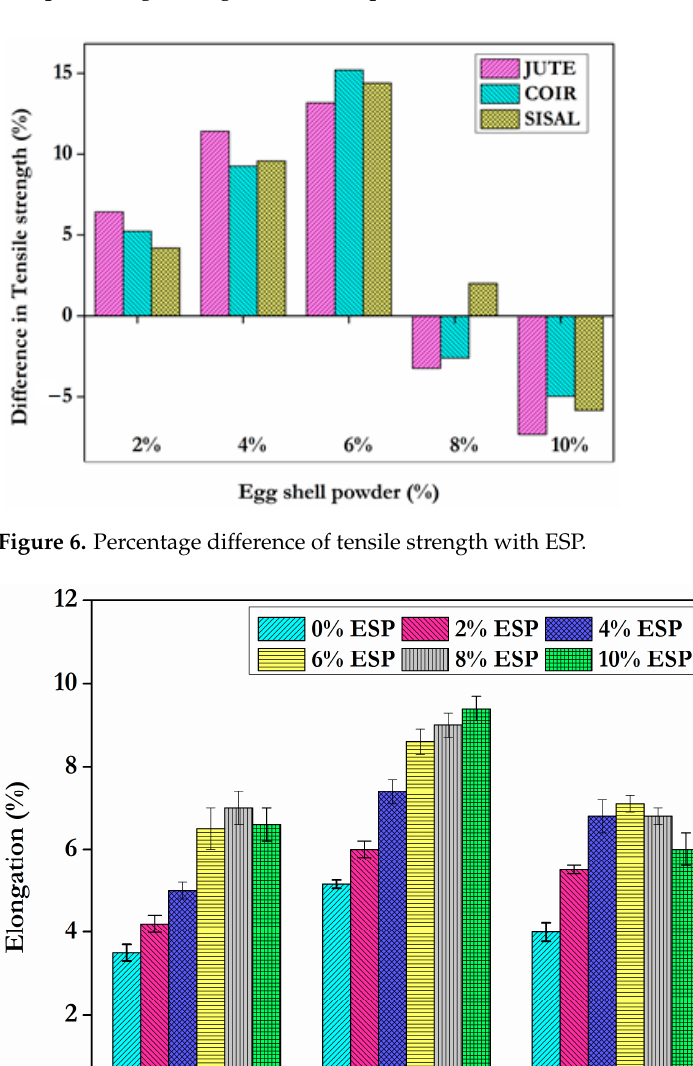
Figure 5. Tensile strengthof composite specimens with different fibres.